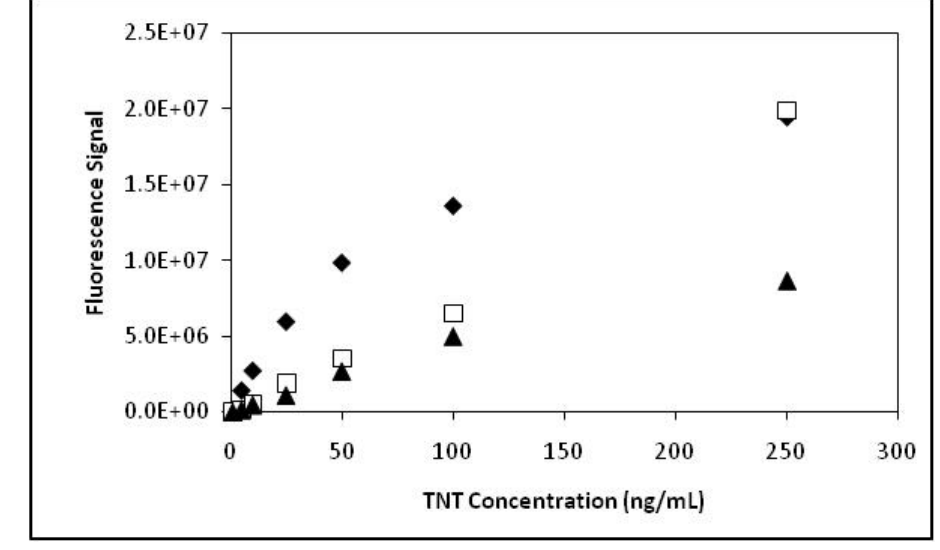
Figure 4. Dose response curves for TNT in seawater using multi-channel PMMA microfluidic device. TNT samples were prepared in 90% seawater: 10% flow buffer (10 mM Na-Phosphate, pH 7.4 + Tween 20 (0.01%). Series 1 (filled diamonds), Series 2 (open squares) and Series 3 (filled